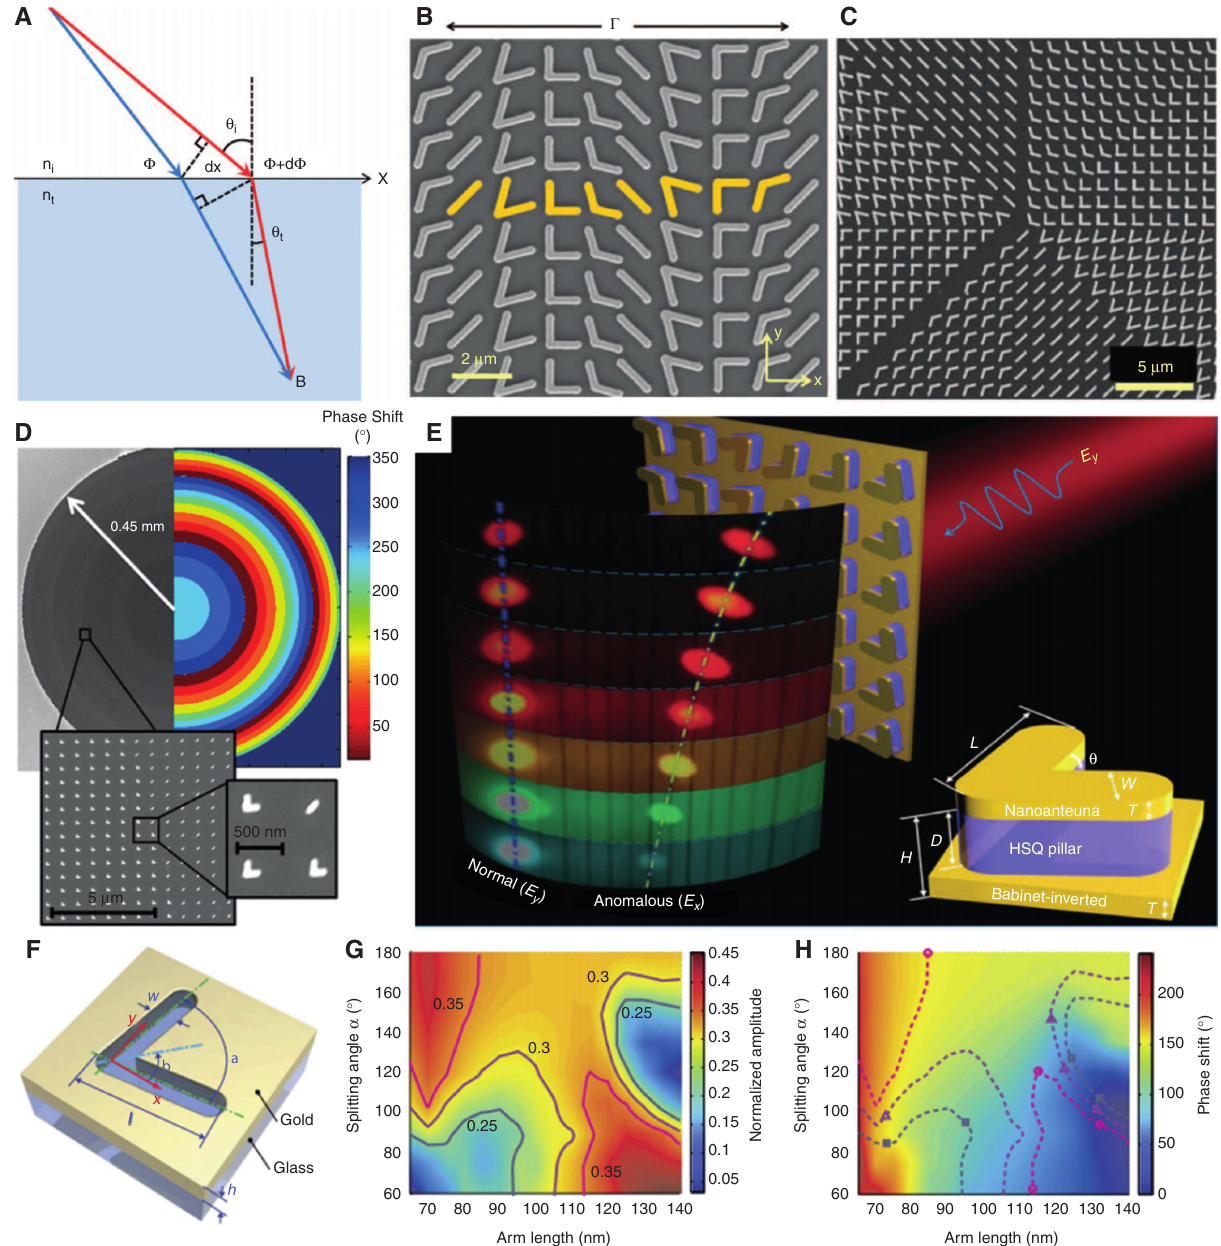
Figure 2: Generalized law of refraction and reflection and V-shaped antennas. (A) Generalized law of refraction and reflection [12]. (B–D) Metagrating [12], spiral phase plate [12], and metalens [13] based on V-shaped antennas. (E) Metagrating based on dual-layer V-shaped antennas [14]. (F–H) Complex amplitude manipulation based on V-shaped